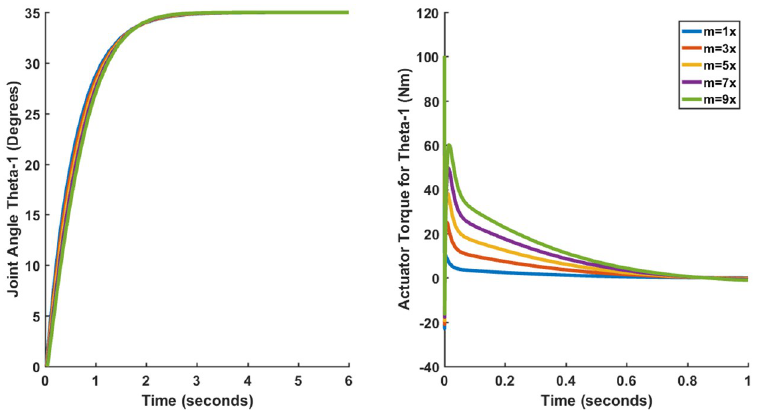
Fig 16. Performance of SFG-SISO (Case I) under mass variation.